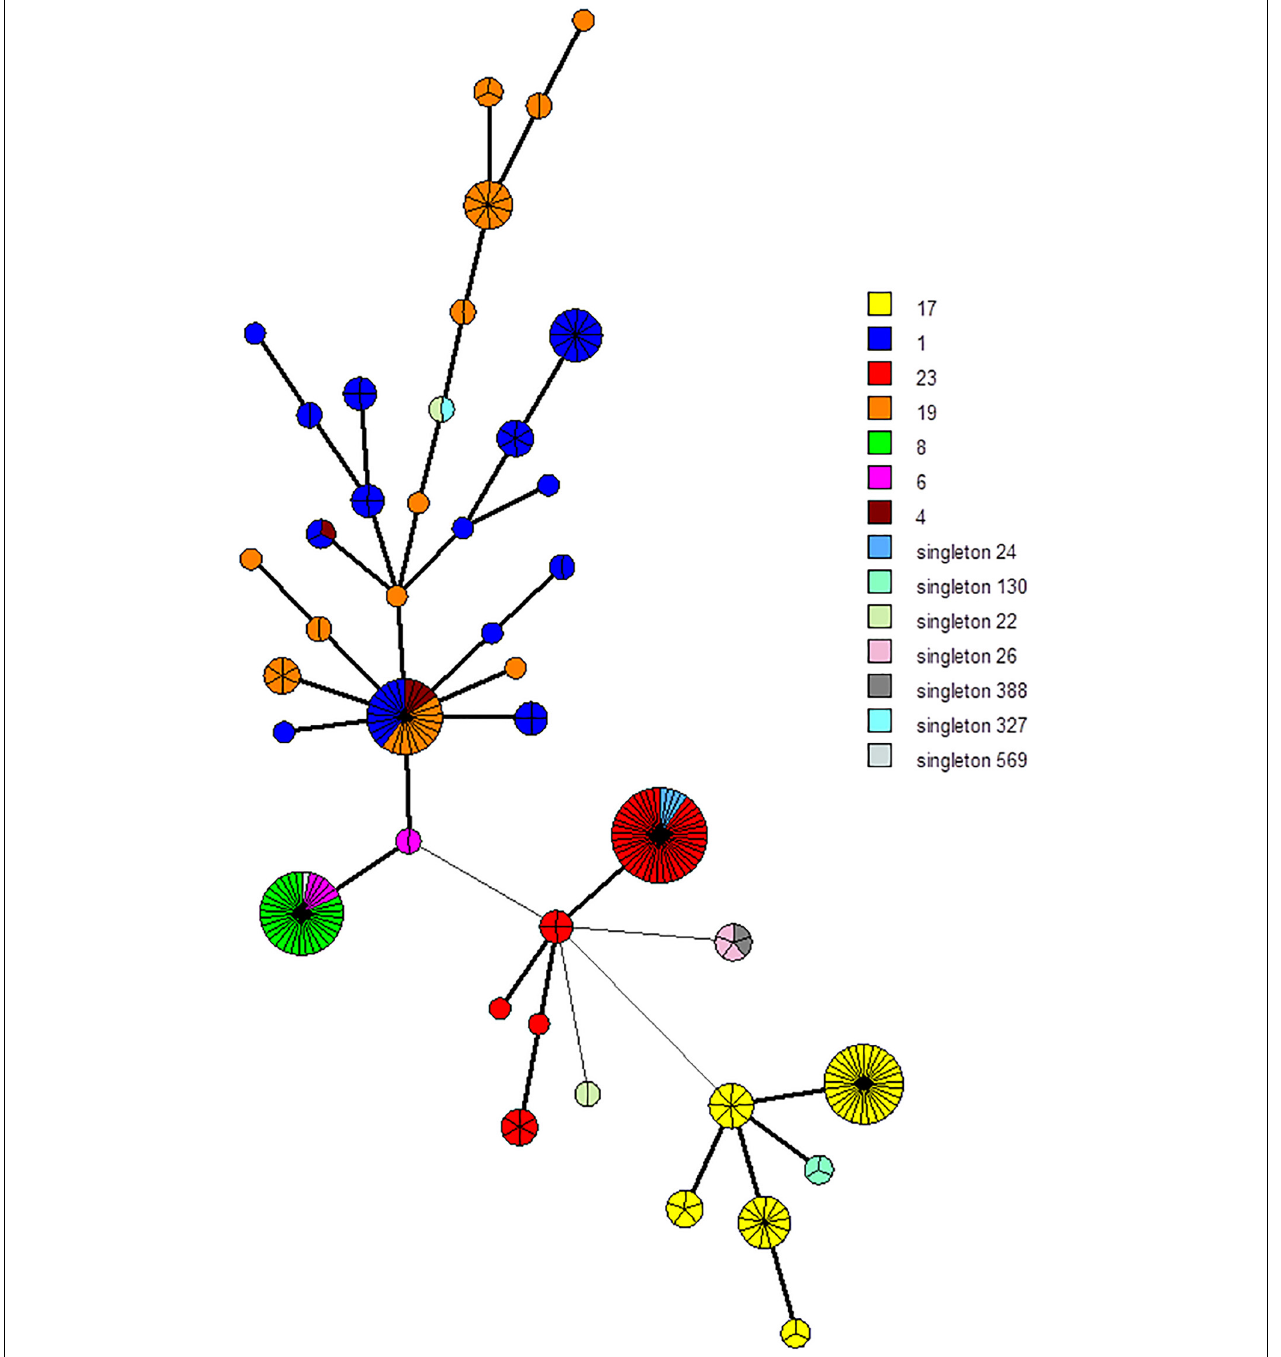
FIGURE 2 | Minimum spanning tree (MST) representation of the 25 CRISPR1 markers scheme clustering. Each circle represents a CRISPR1 genotype and its size is proportional to the number of strains. Each color represents CC or singleton defined by MLST (e.g., yellow for CC17). A high level of correlation between this marker selection and MLST type was observed; circles (representing CRISPR1 genotype) are characterized mostly by a same color, especially for CC17 and CC23, whereas isolates belonging to CC1 and CC19 are more